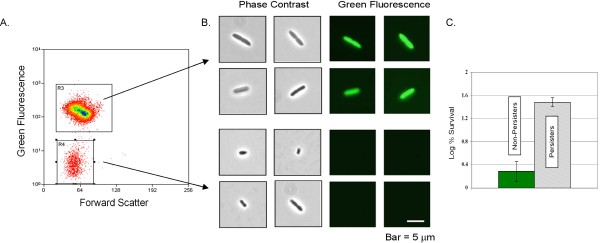
Isolation of persister cells from an exponentially growing culture. E. coli ASV cells containing this reporter cassette were grown in LB medium to mid-exponential phase (~1 × 108 cells/ml) at 37°C with aeration and sorted using a high speed cell-sorter equipped with a standard GFP filter set. (A) Two populations were detected using forward light-scatter, one that fluoresced brightly (R3), and another that did not (R4). (B) The sorted populations were visualized by epifluorescent microscopy (bar, 5 μm). (C) Cells were sorted as described in (A-B). Once sorted both populations were treated with ofloxacin (5 μg/ml) for three hours, diluted and spotted onto LB agar plates for colony counts.